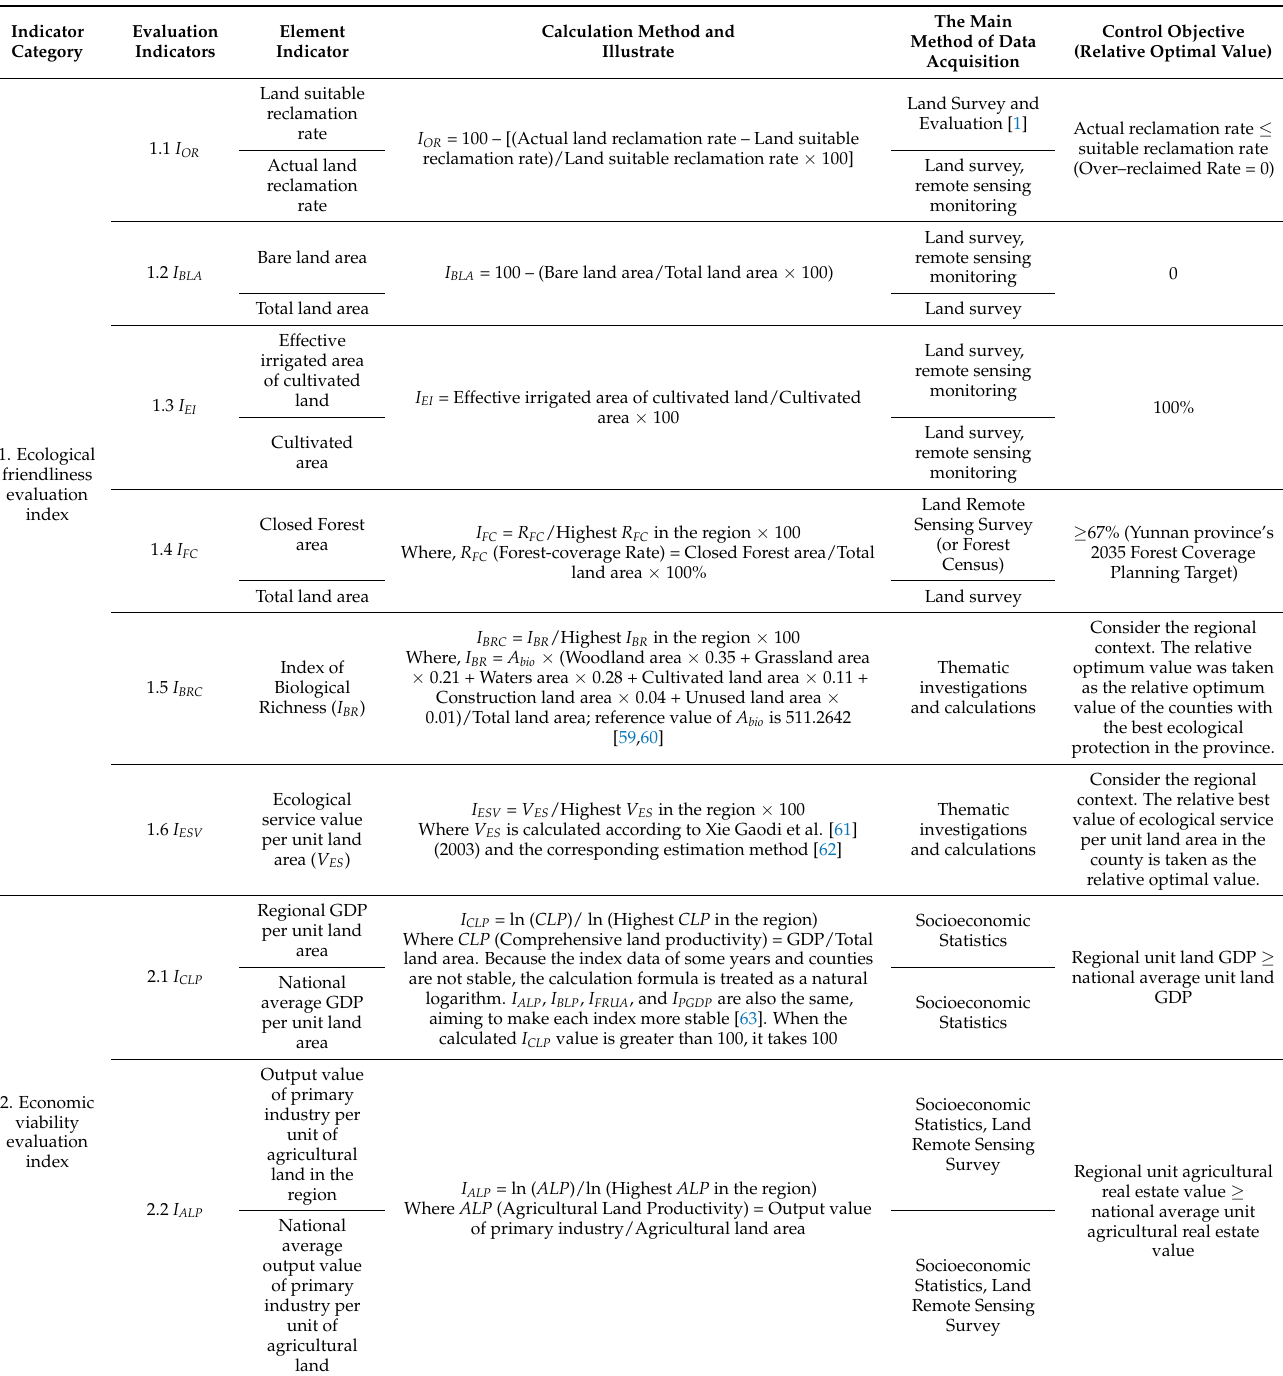
Table 2. Evaluation index system, calculation method, data acquisition method and evaluation standard of LUSE in